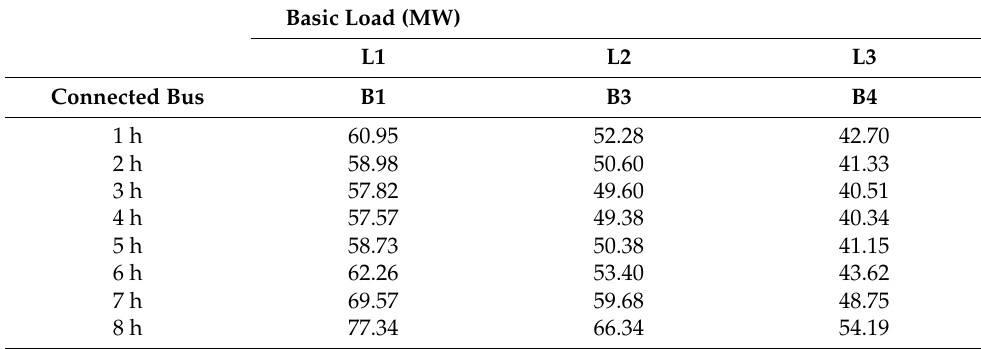
Table A7. Data of the base load in the 6-bus